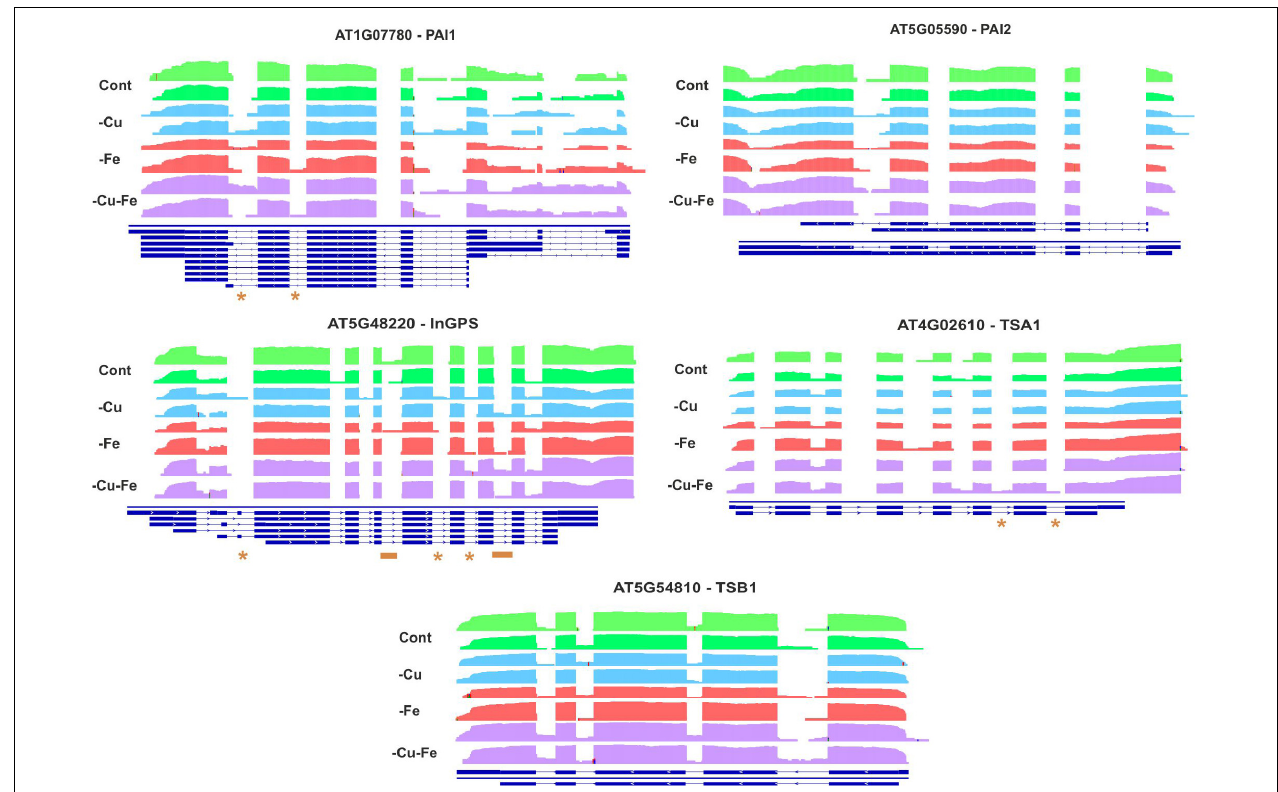
FIGURE 5 | Visualization of alternative splicing events in the transcripts involved in tryptophan biosynthesis under single and simultaneous copper and iron deficiency. Log 10 -transformed read counts were used to represent the RNA-Seq coverage of intronic and exonic regions of PHOSPHORIBOSYLANTHRANILATE ISOMERASE 1 AND 2 (PAI1, 2), INDOLE-3-GLYCEROL PHOSPHATE SYNTHASE (InGPS), TRYPTOPHAN SYNTHASE BETA-SUBUNIT 1 (TBS1), TRYPTOPHAN SYNTHASE A (TSA1) under standard conditions (Cont) and single and double copper and iron deficiencies (–Cu, –Fe, and –Cu–Fe). Differences in the presence of intronic regions are depicted as asterisks (for changes in one replicate under –Fe or –Cu–Fe), or as orange lines (changes exclusive to –Cu–Fe conditions). Blue lines represent the gene model in